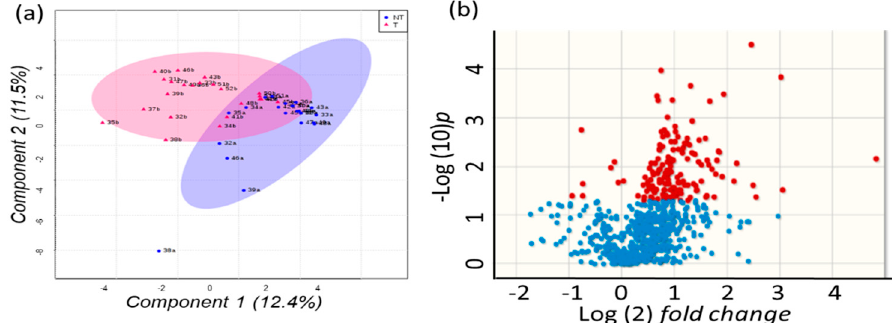
Cancers 2019 , 11 , x FOR PEER REVIEW 7 of 20